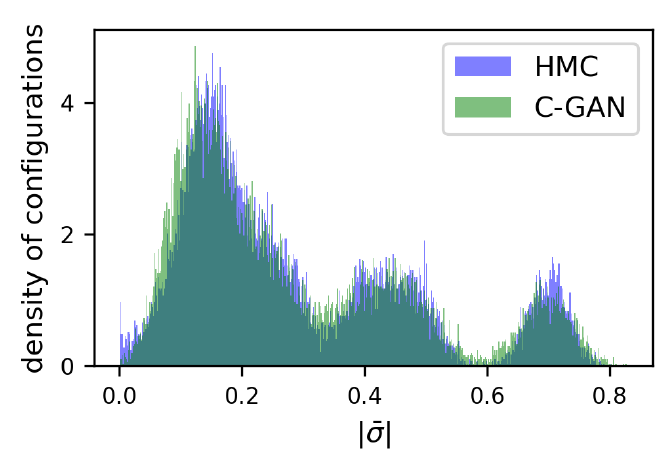
Figure 12: Histogram of | ¯ σ | for Λ tr and C-GAN.